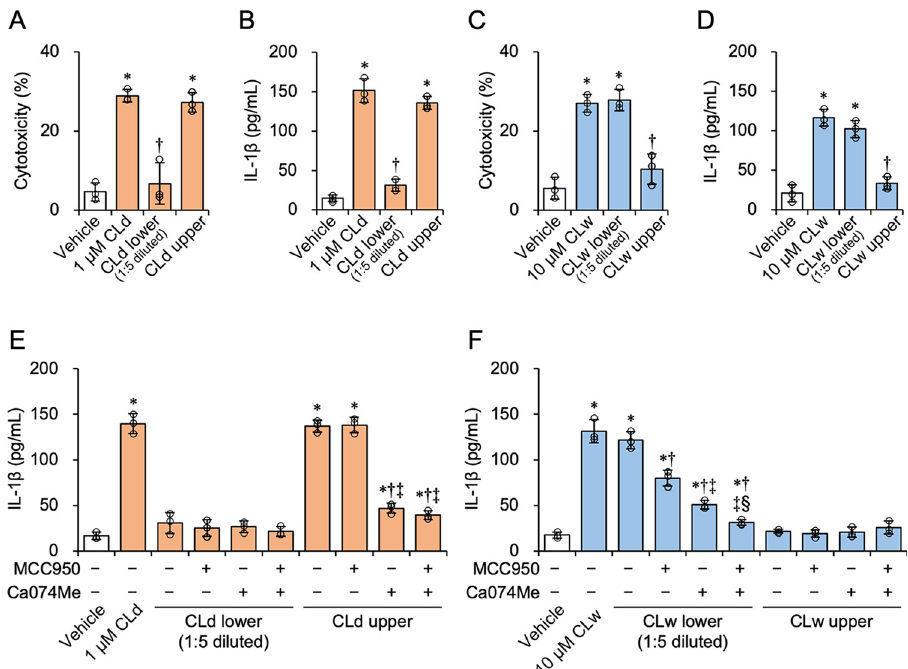
Fig 7. Identification of bioactive fractions of CLd and CLw. A-D: Fractionation of CLd and CLw was performed by centrifugation at 100 × g for 5 min at room temperature. The upper fractions were undiluted, and the lower fractions were diluted five times to restore to their original volume, being used equally with the uncentrifuged peptide solutions. The LPS-primed THP-1 macrophage-like cells were treated with the upper and lower fractions of CLd and CLw for 3 h. The vehicle controls for CLd and CLw are a medium containing 1% DMSO (A and B) and a water-added medium (C and D), respectively. Cytotoxicity was quantified by LDH release assay (A and C), and IL-1 β levels in the culture supernatants were assessed by ELISA (B and D). Data are presented as the mean ± SD (n = 3) and are representative of three independent experiments. � P < 0.05 compared with the vehicle by one-way ANOVA followed by Dunnett’s test ( μ c < μ i). E and F: For simultaneous inhibition assay, the LPS-primed THP-1 macrophage-like cells were pretreated with 2 μ M of the NLRP3 inhibitor MCC950 and/or 20 μ M Ca074Me or with vehicle for 1 h. Cells were then treated with the upper and lower fractions of CLd (E) and CLw (F) for 3 h. The vehicle controls for CLd and CLw are a medium containing 2% DMSO (E) and a medium containing 1% DMSO (F), respectively. The IL-1 β levels in the culture supernatants were assessed by ELISA. Data are presented as the mean ± SD (n = 3) and are representative of three independent experiments. � P < 0.05 compared with the vehicle ( μ c < μ i); † P < 0.05 compared with the no inhibitor control ( μ c > μ i); ‡ P < 0.05 compared with the single use of the first inhibitor ( μ c > μ i); § P < 0.05 compared with the single use of the second inhibitor ( μ c < μ i) by one-way ANOVA followed by Dunnett’s